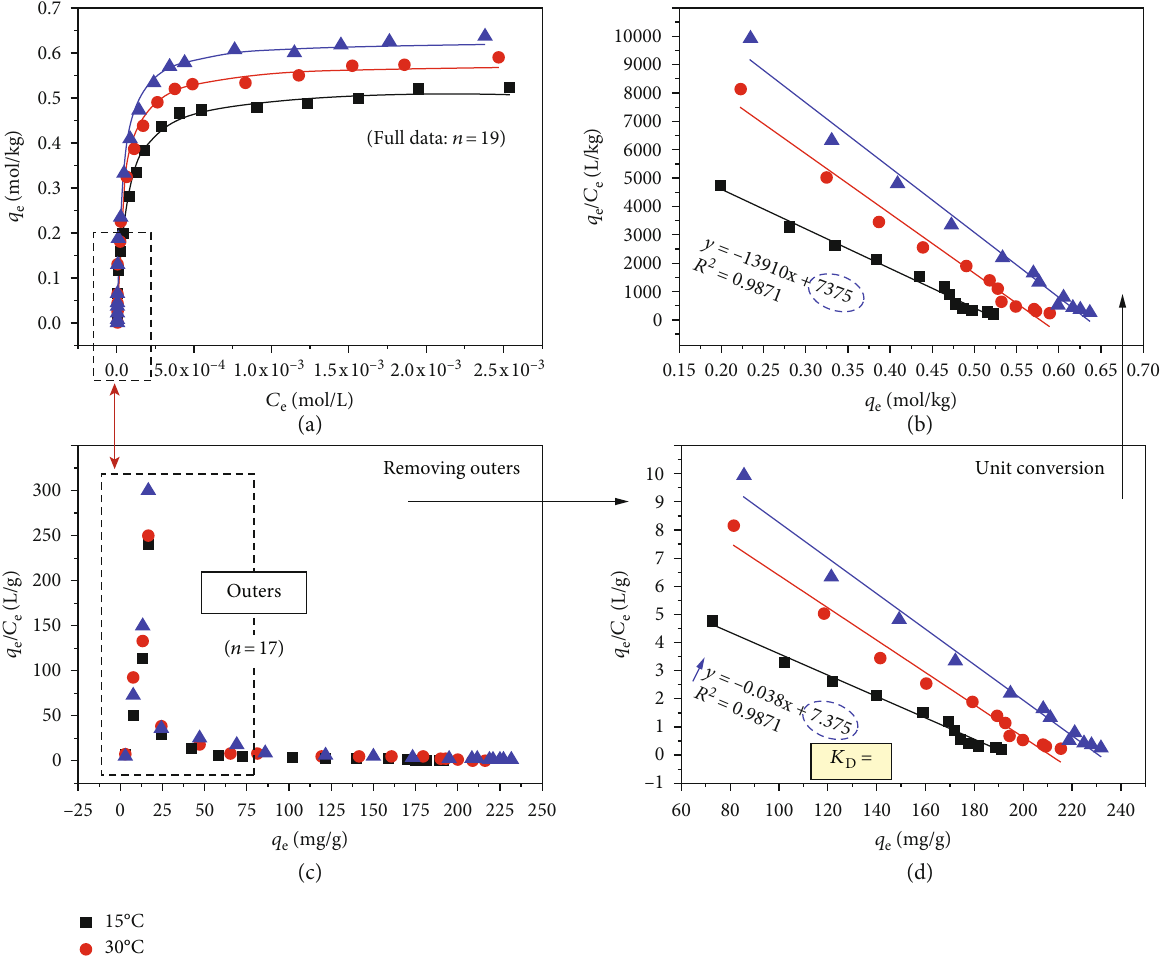
Figure 2: (a) Adsorption isotherm of methylene green dye onto commercial activated carbon [24]; and (b) – (d) the di ff erent plots of q q for determining constant K e